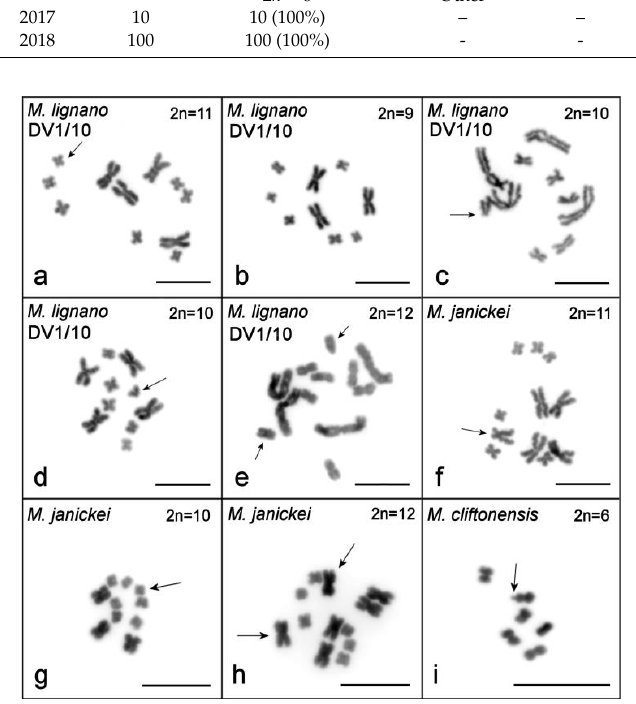
Figure 2. Metaphase plates from specimens with abnormal karyotypes: ( a – e ) DV1/10 line of M. lignano ,